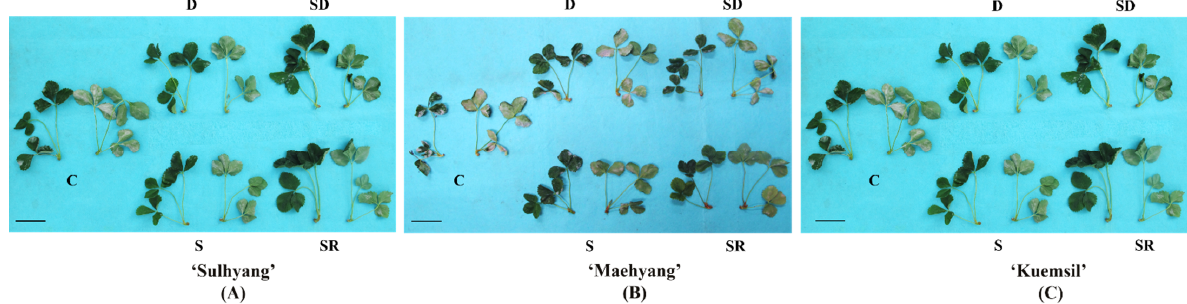
Figure 1. Photographs showing the front and back of leaves of the “daughter” plant ( A ) ‘Sulhyang’; ( B ) ‘Maehyang’; and ( C ) ‘Kuemsil’ infected by the powdery mildew: C, control; S, sprayed “mother” plant; D, drenched “mother” plant; SD, dressed “mother” plant; and SR, sprayed “daughter” plant. Bars indicate 10 cm.